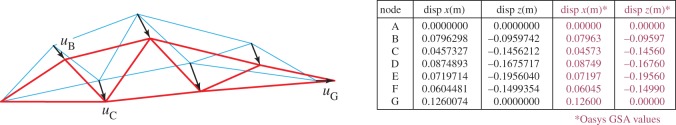
The deformed shape (red).